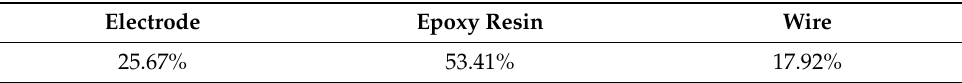
Table 1. The mass ratio of each physical component in the EcSETCs (wt.%).